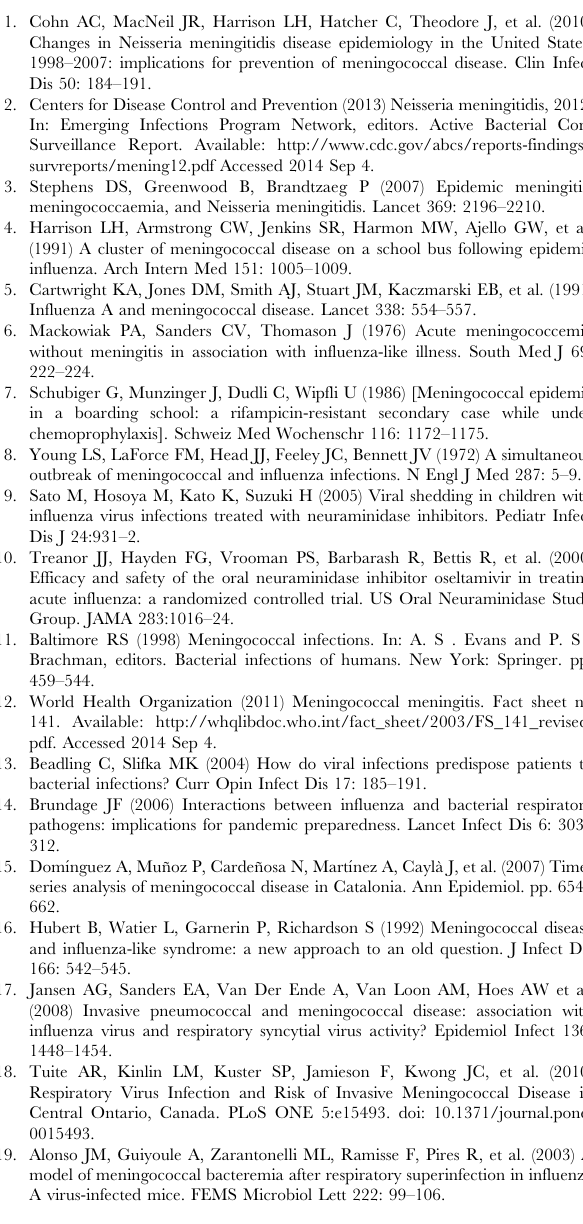
Table S5 Synchrony of meningococcal disease and influenza hospitalizations peak week by state. Text S1 Supporting information. Section S1, Missing data. Section S2, Comparing incidence rates of meningococcal disease hospitalizations from multiple data sources. Section S3, Modeling approach. Section S4, Testing for unmeasured confounding. Section S5, The effect of age on the fraction of meningococcal disease attributable to influenza. Section S6. Spatial heterogeneity in the association between influenza and meningococcal disease